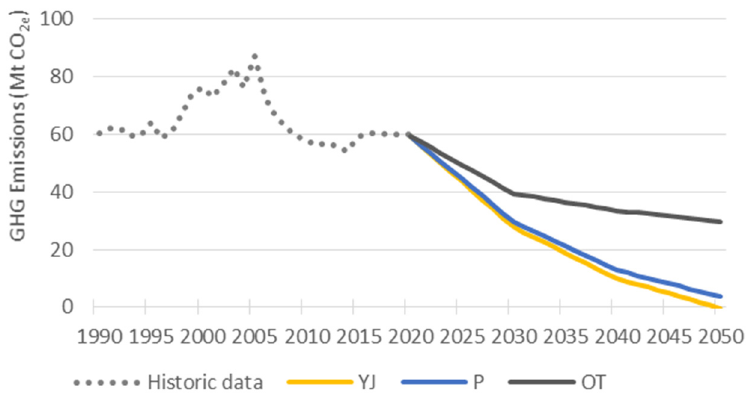
Figure 3. Greenhouse gas (GHG) emission trajectories for three studied scenarios (Mt of CO 2e including land use, land use change and forestry (LULUCF)).